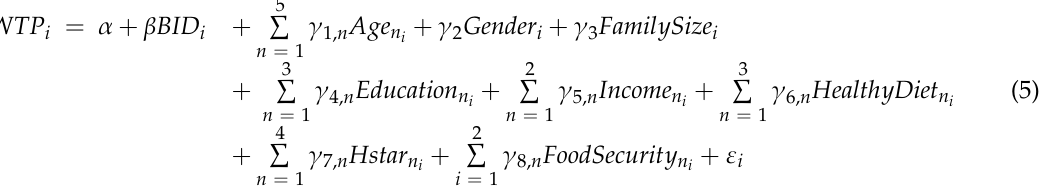
Table 1 defines all the variables included in the model. Maximisation of the related log-